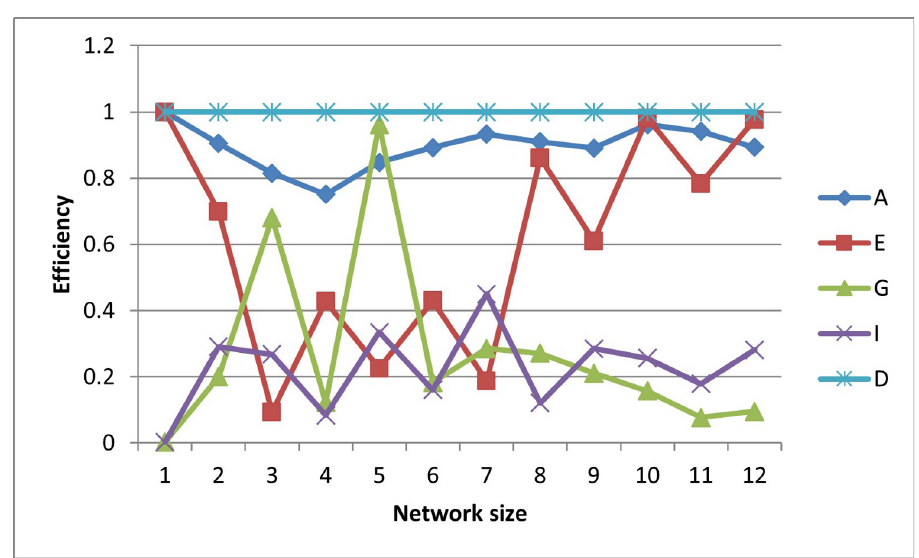
Fig 17. D-efficiencies of various optimal designs for the second case study.